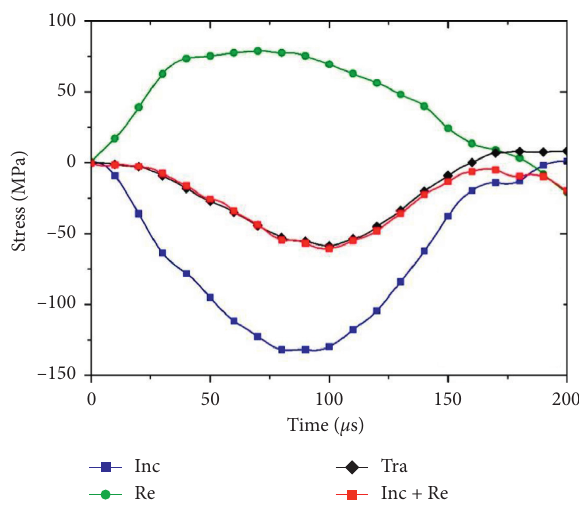
Figure 4: Typical stress equilibrium relationship of specimen U-0-3.